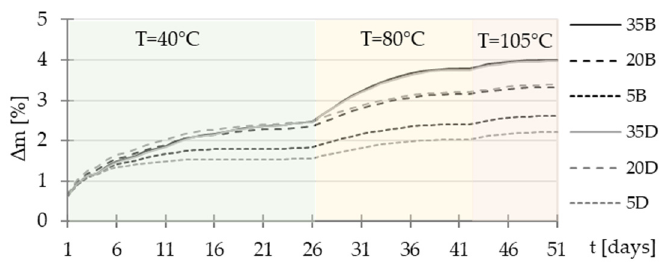
Figure 2. Scheme of drying process.